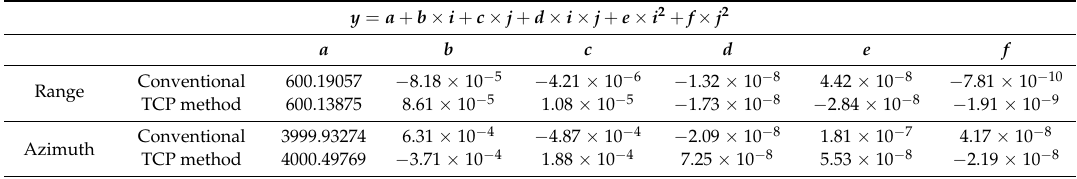
Figure 6. TCP network constructed by ( a ) global Delaunay triangulation and ( b ) local Delaunay triangulation. Black dots and gray lines indicate the temporarily coherent points (TCPs) and the arcs, respectively. The figure is plotted in the World Geodetic System (WGS) 84 coordinate system.